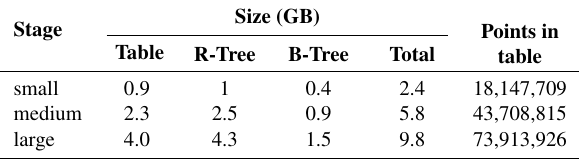
Table 8: The storage requirements of the validation.